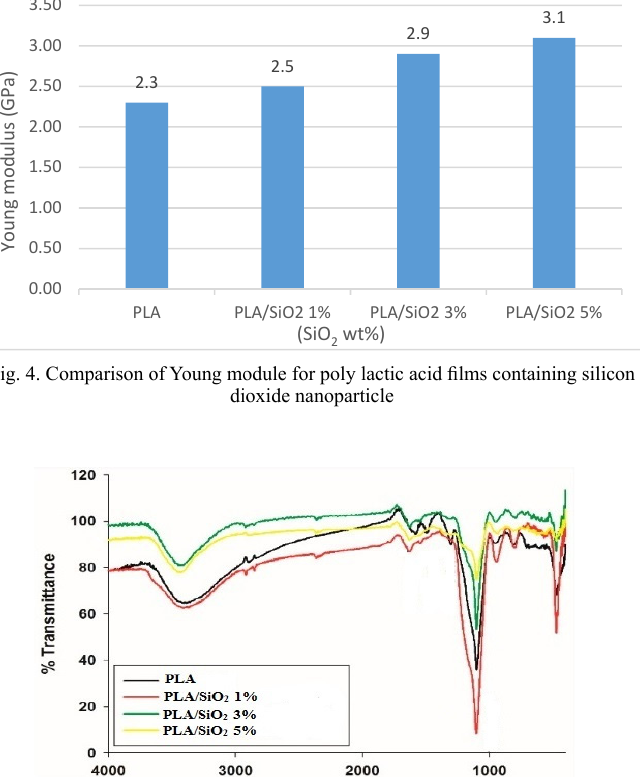
144 Nanomed Res J 3(3): 140-145, Summer